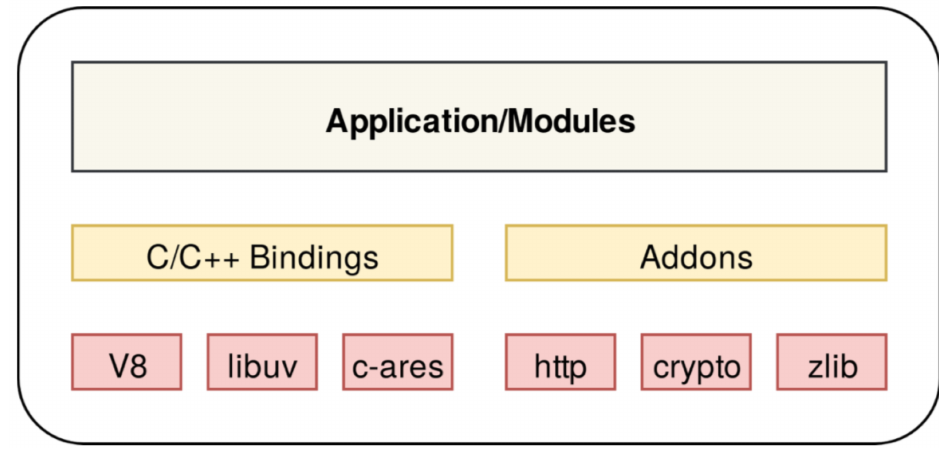
Figure 1. Abstracted Node.js application